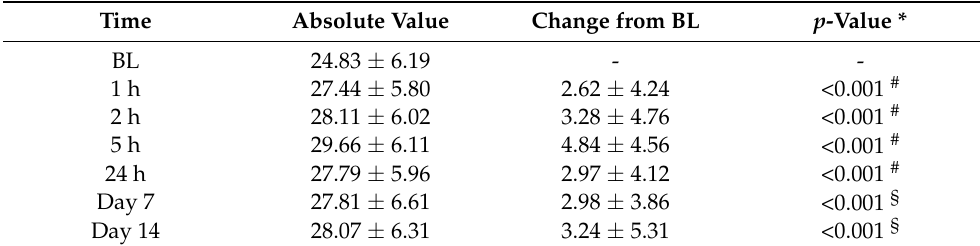
Table 5. Absolute skin capacitance measurement values (forearm, area A1) and changes from the baseline after a single application of the body wash gel (first 24 h) followed by once-daily applications for 13 days. Time Absolute Value Change from BL p -Value * BL 24.83 ± 6.19 - - 1 h 27.44 ± 5.80 2.62 ± 4.24 <0.001 # 2 h 28.11 ± 6.02 3.28 ± 4.76 <0.001 # 5 h 29.66 ± 6.11 4.84 ± 4.56 <0.001 # 27.79 ± 5.96 28.07 ± 6.31 <0.001